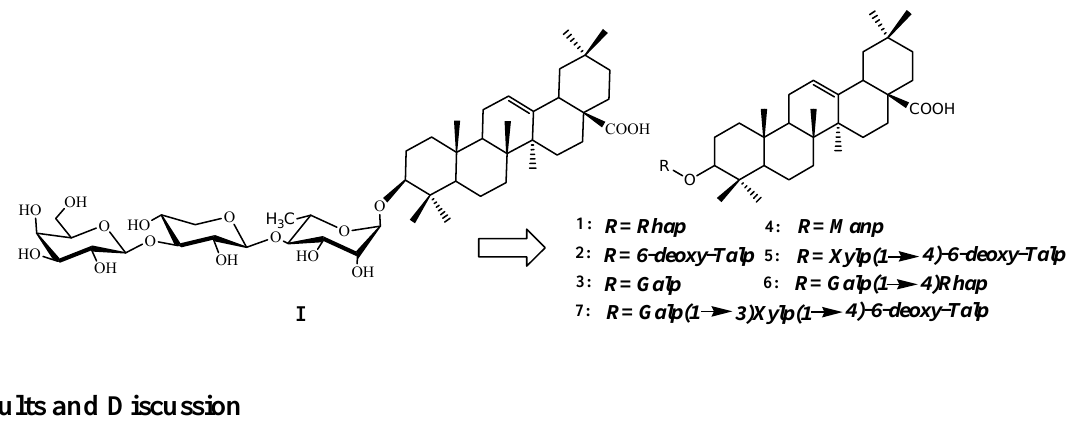
Figure 1. Structure of the triterpenoid saponin ( I ) and target compounds 1 – 7 .